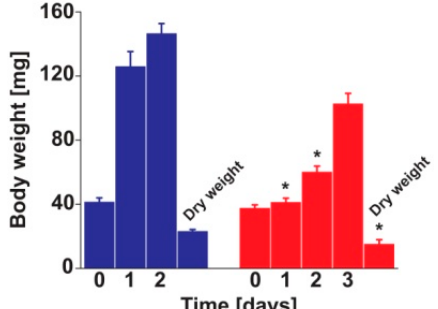
Figure 1. Growth rate of herbivore (blue) and cannibal (red) Helicoverpa armigera larvae. Weight of individual larvae was recorded from the moment a group of larvae was switched from herbivore diet to cannibalism. Larvae were in third instar at the beginning of the experiment. Bars represent mean and standard error of the mean; t -tests were computed to identify differences between diets at specific days (* p > 0.05).